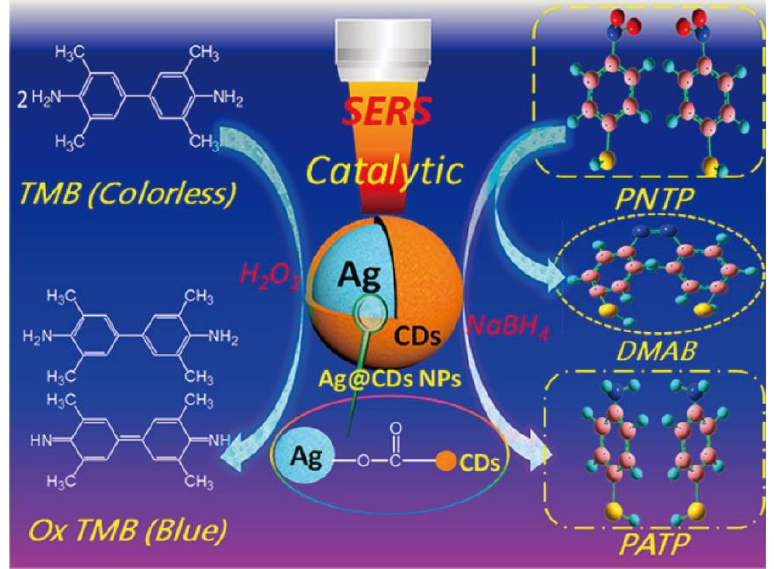
Figure 9. Schematic illustration of the Ag@CDs NPs catalyzed reduction of PNTP to PATP. Reprinted with permission from [61]. Copyright 2016 American Chemical Society.